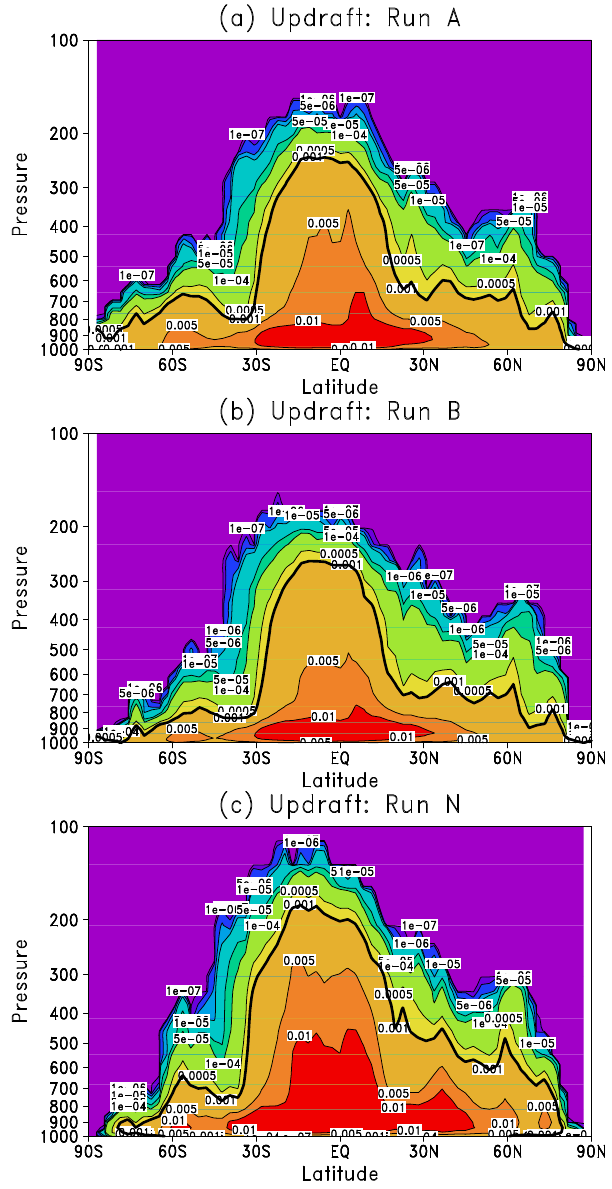
Fig. 5. Zonal mean convective updraft mass flux (kgm − 2 s − 1 ) for runs (a) “A E40”, (b) “B EI”, and (c) “N 1991” averaged from 27 December 1990–11 January 1991. The bold contour indicates 0.001kgm − 2 s − 1 .